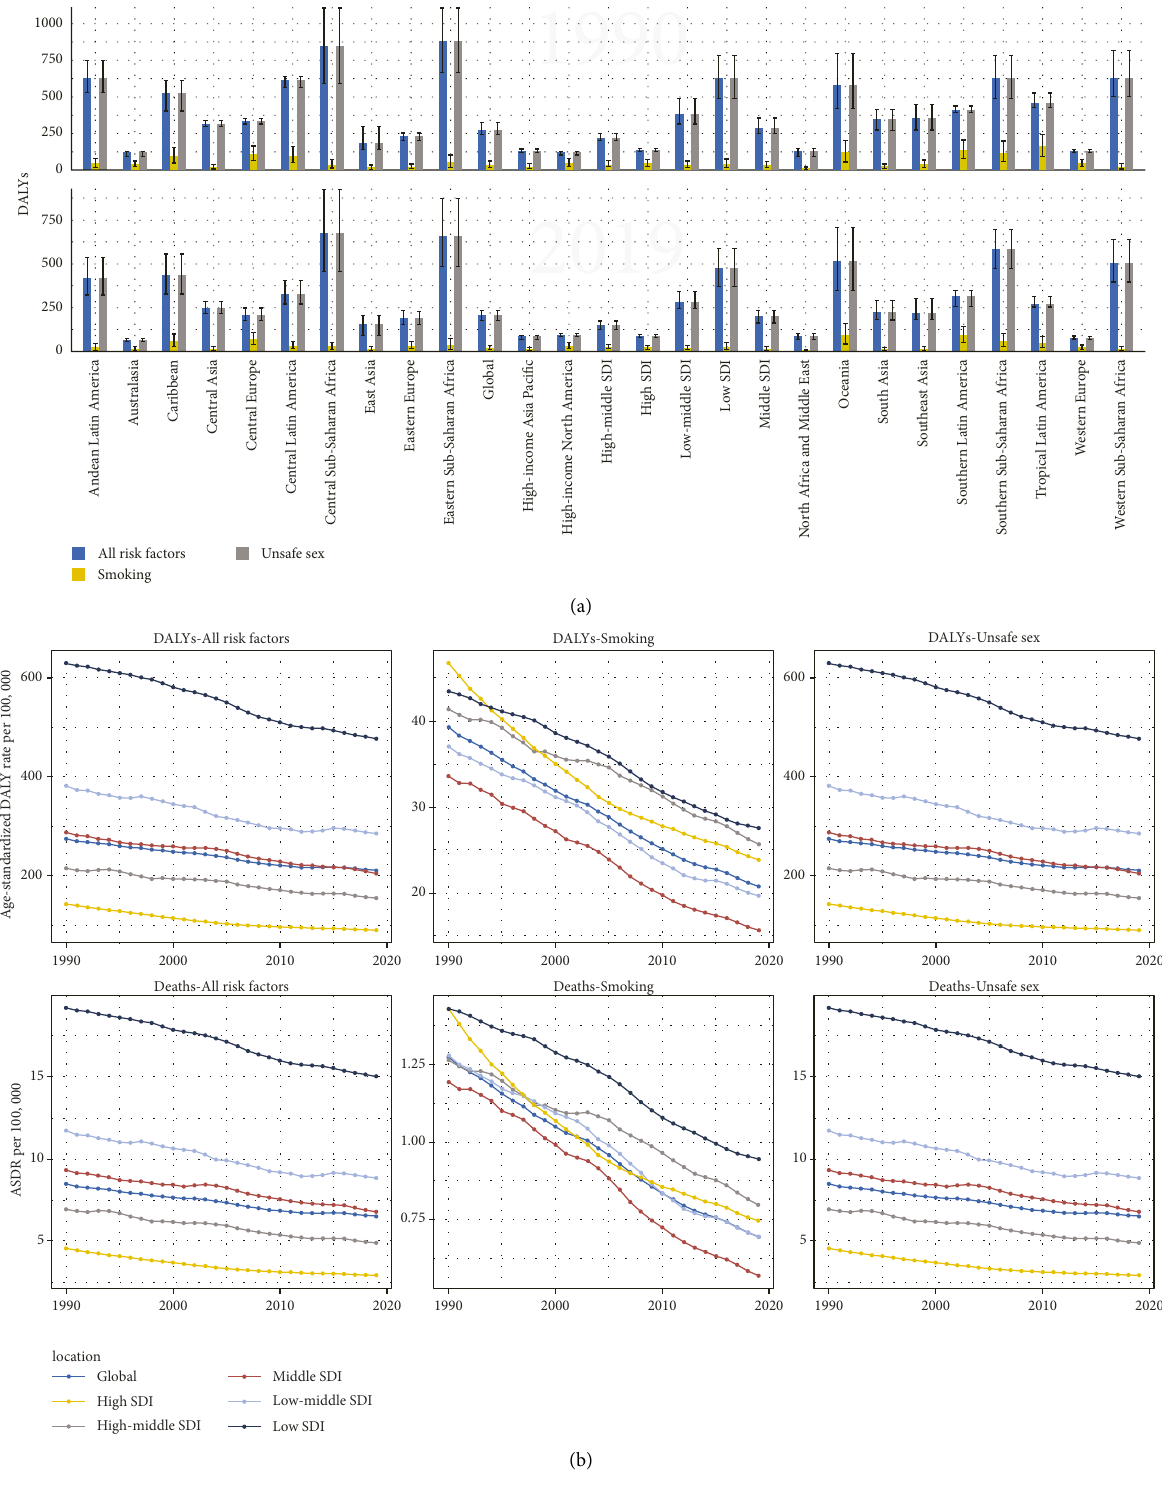
Figure 4: Cervical cancer DALY (a), age-standardized rates of DALY, and ASDR (b) attributable to risk factors compared in 1990 and 2019. DALY, disability-adjusted life-years; ASDR, age-standardized death